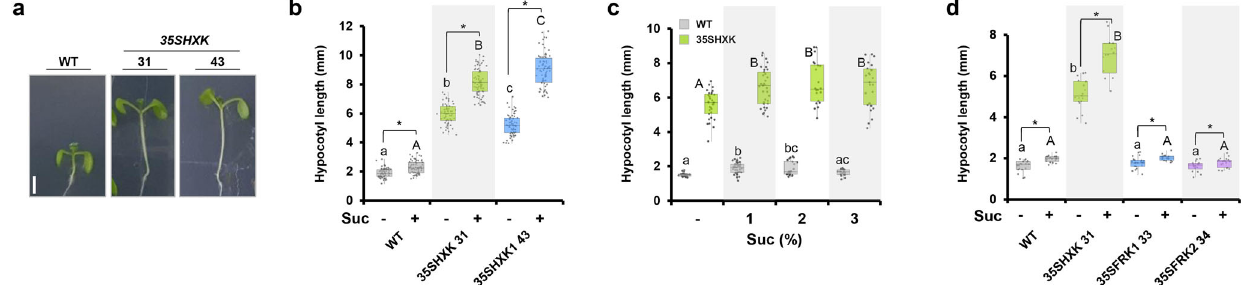
Fig. 1 Hexokinase promotes hypocotyl elongation. a – d Seedlings were grown under long-day (16 h light/8 h dark), white-light (40 µ molm − 2 s − 1 ) conditions for 7 days. a Representative images of 7-day-old 35SHXK seedlings. Bar = 2 mm. b Hypocotyl lengths of 35SHXK seedlings grown with and without 1% sucrose. Data from two independent lines (#31, #43) are shown. c Hypocotyl lengths of 35SHXK seedlings treated with increasing concentrations of sucrose. d Hypocotyl lengths of 35SHXK , 35SFRK1 and 35SFRK2 seedlings grown with and without 1% sucrose. b – d The box plots extend from the fi rst to third quartiles and the whiskers extend from the minimum to the maximum levels. Lines within the boxes signify median values and light gray dots represent individual data points ( n = 55 – 70 for b ; n = 20 – 30 for c ; n = 15 – 25 for d ). Different lower-case and capital letters indicate signi fi cant differences (Tukey ’ s HSD test, P < 0.05). Asterisks indicate signi fi cant differences between the compared treatments ( t test, P <